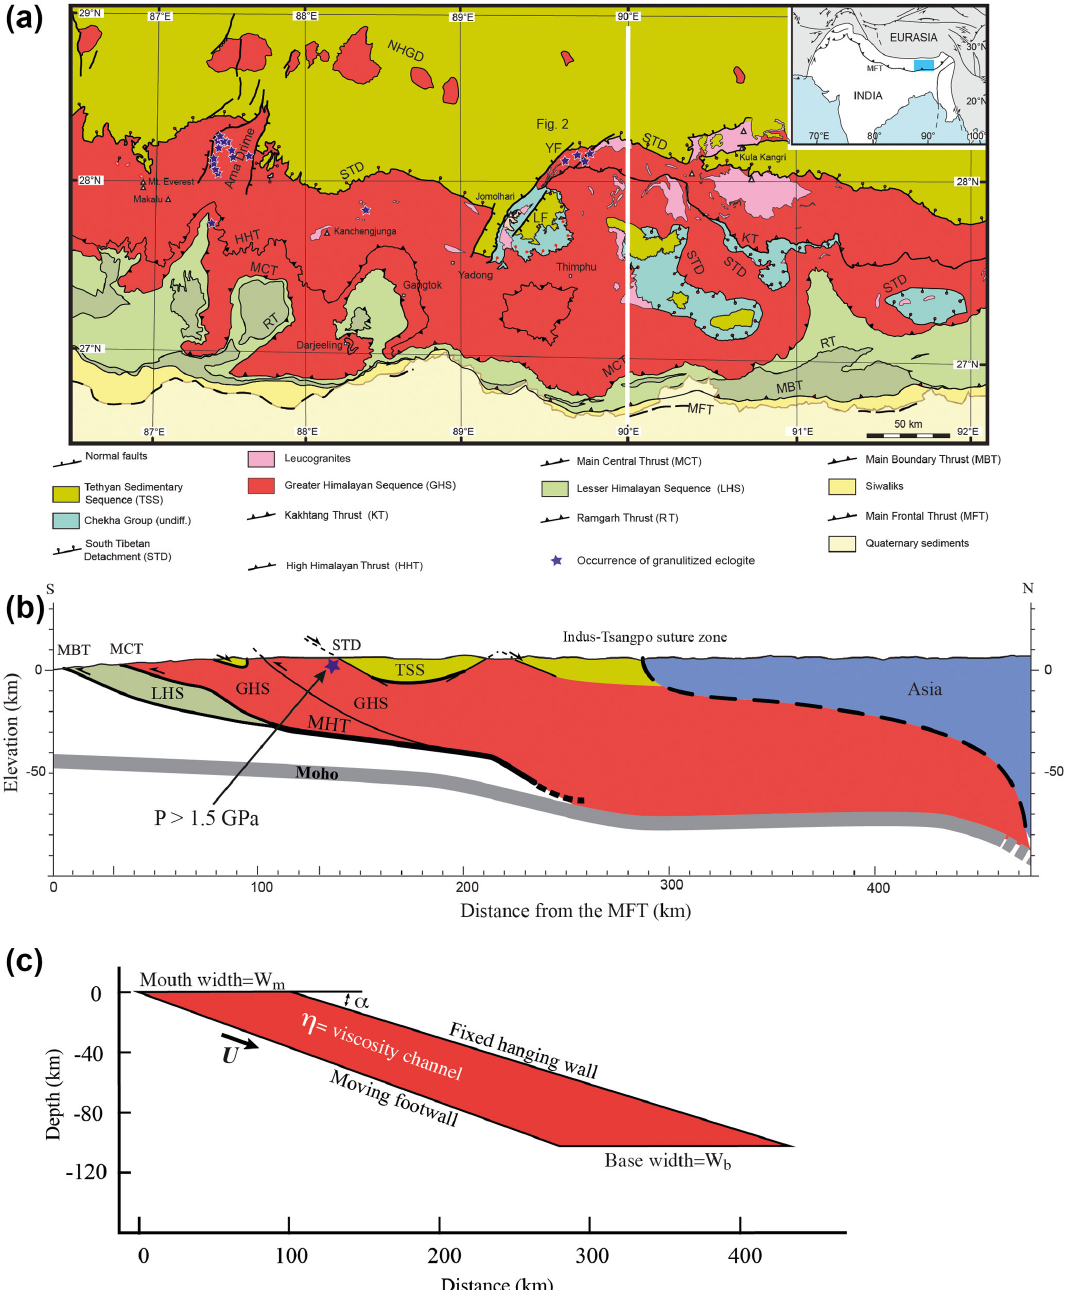
Figure 1. Geological setting of the eastern Himalayas, highlighting the architecture of its major tectonic elements. (a) Simplified geological map of the eastern Himalayas (adapted from Grujic et al., 2011 and Unsworth et al., 2005). White line along 90 ◦ E marks the cross section shown in (b) . (b) Schematic section across the Himalayas (adapted from Grujic et al., 2011), in which the UTC stands out (GHS in red). The GHS is bounded at the top by the South Tibet Detachment (STD) and at the bottom by the Main Central Thrust (MCT). MHT is the Main Himalayan Thrust. (c) Model set-up of the UTC, with shape and dimensions similar to the natural prototype in (b) . The “footwall” (moving wall) and the “hanging wall” (no-slip wall) correspond to the MCT and the STD, respectively. Apart from the later folding of both MCT and STD, the similarity between nature and model set-up is